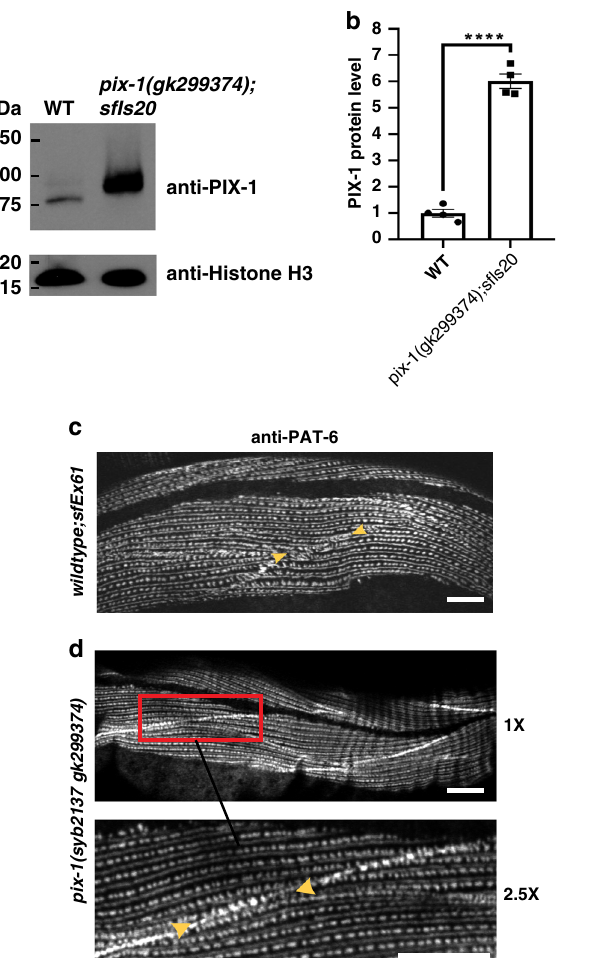
Fig. 5 Overexpression of pix-1 results in disruption and CRISPR repair of pix-1(gk299374) results in normalization of muscle cell boundaries. a , b Western blot analysis showing overexpression of PIX-1 in the strain [ pix-1(gk299374); sfIs20 ] in which the muscle cell boundary defect observed in the nonsense mutant pix-1(gk299374) has been rescued by an integrated array of wild-type pix-1 expressed from a muscle-speci fi c promoter (see Fig. 1c). a A representative western blot is shown reacted with antibodies to PIX-1, and to the loading control histone H3. b Graphical summary of four independent western blot reactions for wild type vs. pix-1(gk299374); sfIs20 . Means and standard errors of the means are shown. The two strains show statistically different levels of PIX-1 using a two-sided students t -test with p < 0.0001 (indicated by ****). Images of the entire western blots are provided in the Source Data Files. c This same array when expressed in a wild-type background [wild-type; sfEx61 ] disrupts the muscle cell boundary. d pix-1(syb2137gk299374) is pix-1(gk299374) after CRISPR/Cas9 was used to repair the nonsense mutation. Confocal images of anti-PAT-6 are shown and reveal that the muscle cell boundary is normal. This is further evidence that the muscle cell boundary defect is due speci fi cally to mutation in the pix-1 gene. Arrowheads point to muscle cell boundaries visualized by immunostaining with anti-PAT-6. Each image is a representative image obtained from at least 2 fi xation and immunostaining experiments, and imaging at least three different animals. Scale bars, 10 μ